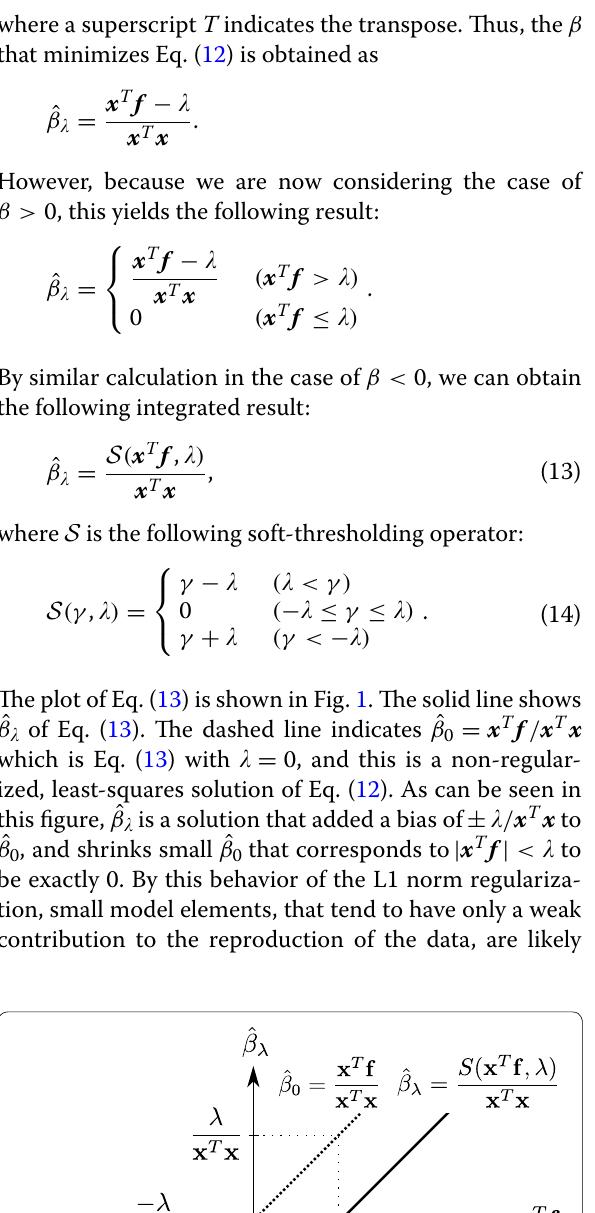
x T f / x T x , β 0 ˆ =